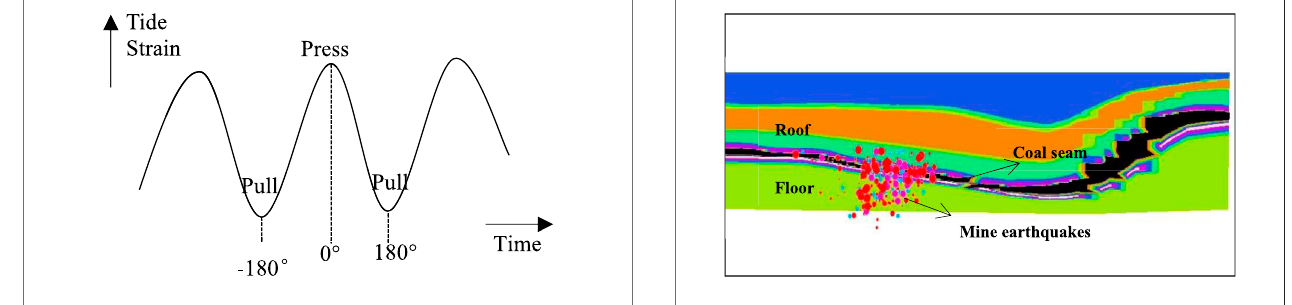
FIGURE 1 | Phase Angle of the tide. FIGURE 2 | Mine earthquake activity distribution